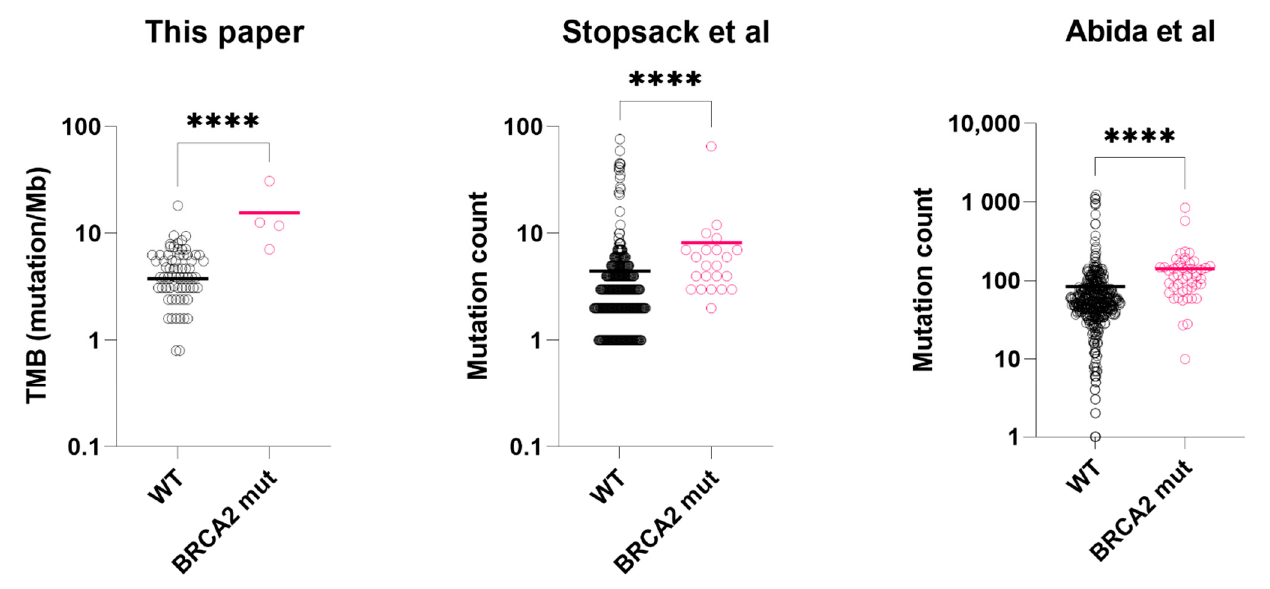
Figure 2. Tumor mutation burden or mutation count of BRCA2 -mutated prostate cancer vs. wild-type prostate cancer tissues. From left to right: tumor mutation burden (mutation/Mb), data from this paper; tumor mutation count (total), data from Stopsack et al.; tumor mutation count (total), data from Abida et al. Asterisks: **** p < 0.0001. black circle: BRCA2 wild-type sample (WT); pink circle: BRCA2 mutated sample (mut). Colored bar = median. Datasets: This paper, TCGA. [24], Stopsack et al. [23], Abida et al. [22], Wei et al. [6].